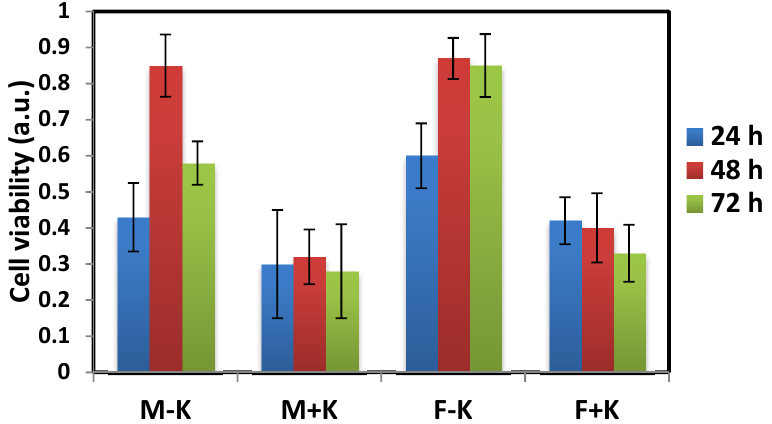
Figure 9. Cell viability on the keratin ‐ coated plates was determined by WST assay after 24, 48 and 72 h incubation. M stands for MDA breast cancer cells, K stands for keratin and F is for fibroblast cells. Error bars were obtained from three independent measurements.